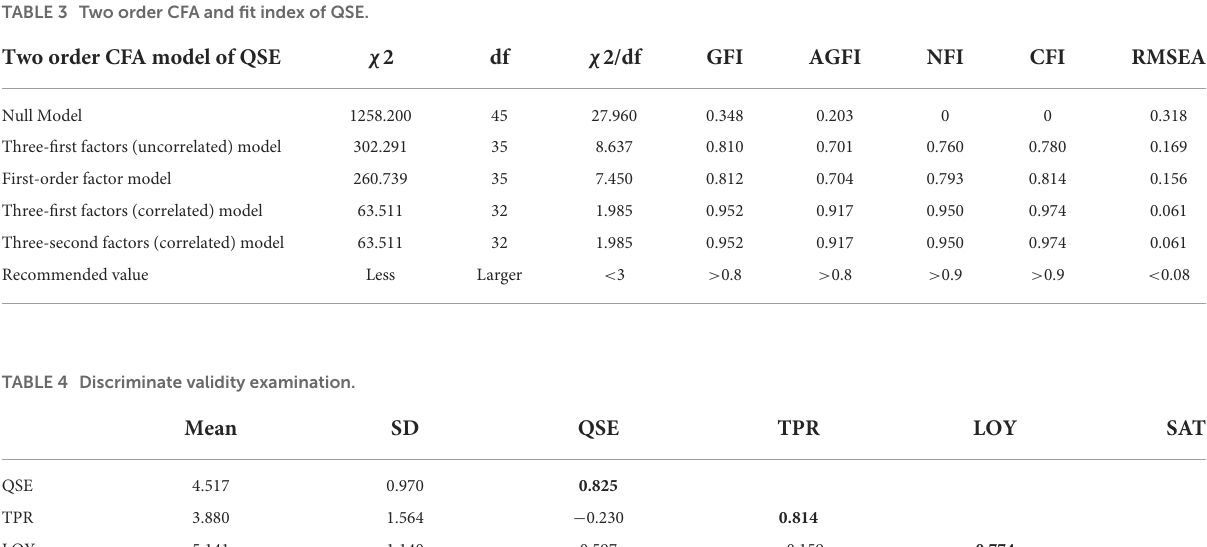
TABLE 3 Two order CFA and fit index of QSE.